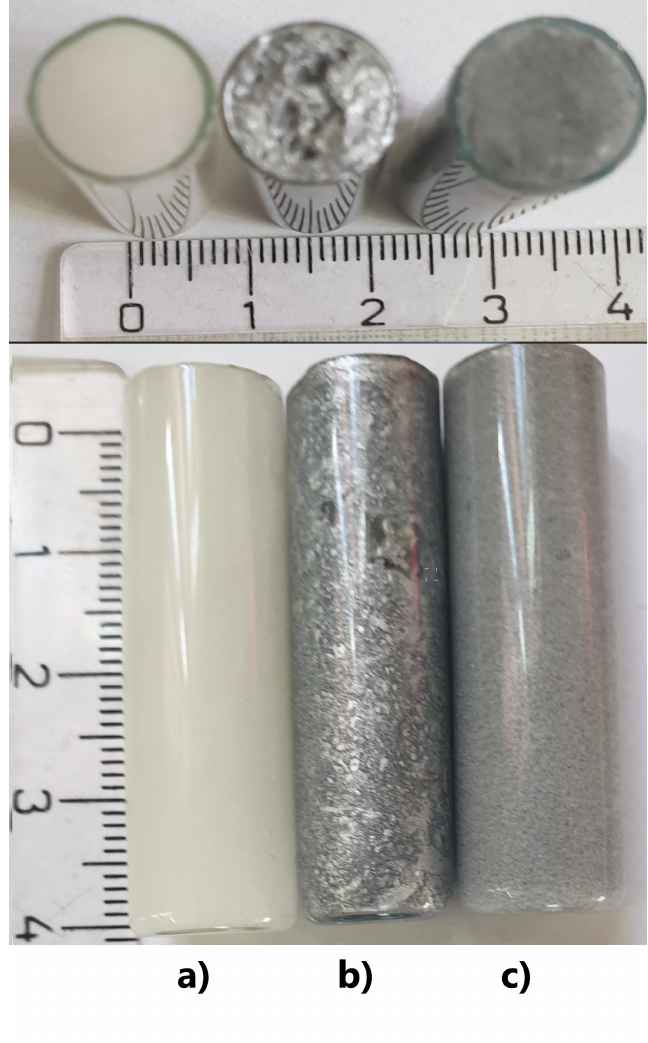
Figure A6. Photographs of OSM samples taken when 24 h have elapsed after their preparation ( a ) OSM-0, ( b ) OSM-Al f , ( c ) OSM-Al A